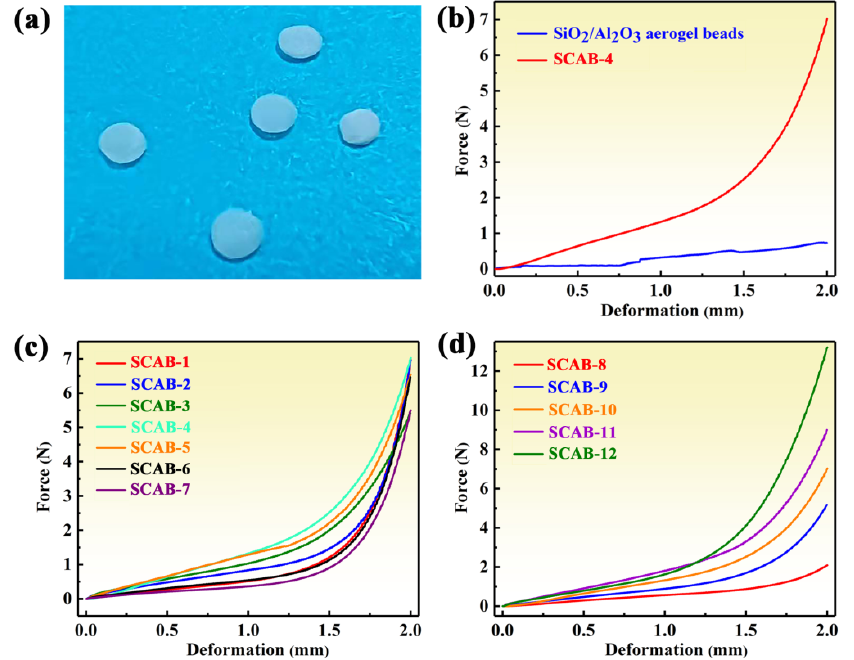
Figure 7. ( a ) Photos of SCABs after compression test. Compressive force–deformation curves of ( b ) native SiO 2 –Al 2 O 3 aerogel beads and SCAB-4, ( c ) SCAB 1–7, ( d ) SCAB 8–12. The shape of the samples is spherical, which causes the cross-sectional areas to change continuously during the compression process, so the x ‐ and y ‐ axes in ( b – d ) are respectively represented by deformation and force. The effect of agarose concentration on the compressive strength of SCABs was fur ‐ ther studied. With the increase of agarose concentration, the difference of compressive force of the SCABs was relatively small before the deformation reached 1.3 mm, whereas